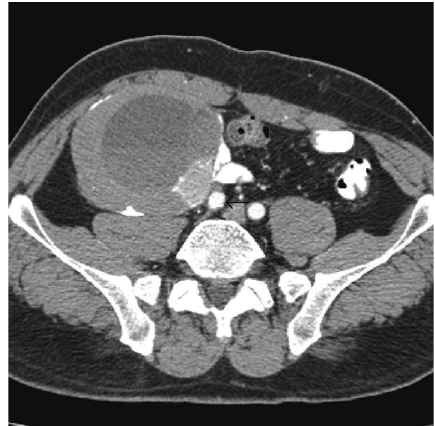
Figure 2: On enhanced CT, the wall and septa were not enhanced.